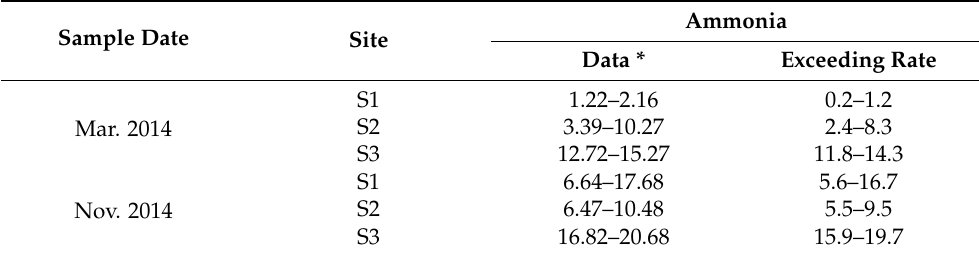
Table 3. Concentration of ammonia in pore water of the